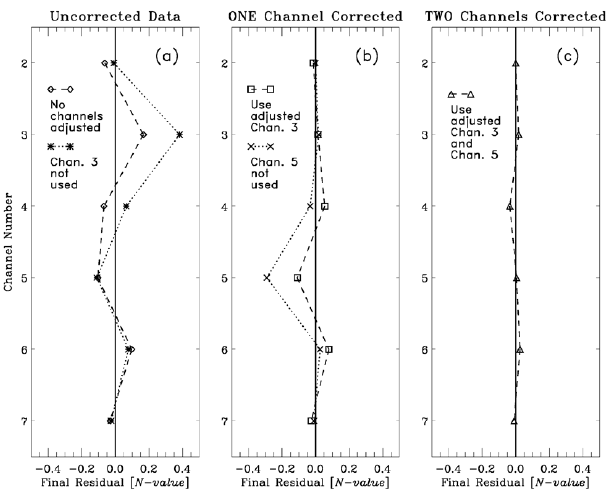
Fig. 6. Determination of individual channel calibration adjustments using final residuals. All results are based on NOAA-17 data aver- aged over the Pacific Ocean and equatorial latitudes, using only low reflectivity measurements ( R < 10%). (a) Diamonds show resid- uals with no adjustments. Asterisks show residuals when chan. 3 (283.1nm) is excluded from retrieval processing. (b) Squares show residuals when chan. 3 calibration is adjusted based on the error shown in the “excluded” case from (a) . Crosses show the residuals when chan. 5 (292.3nm) is excluded from this processing. (c) Trian- gles show residuals when the calibration for both chan. 3 and chan. 5 is adjusted based on the errors shown in the “excluded”